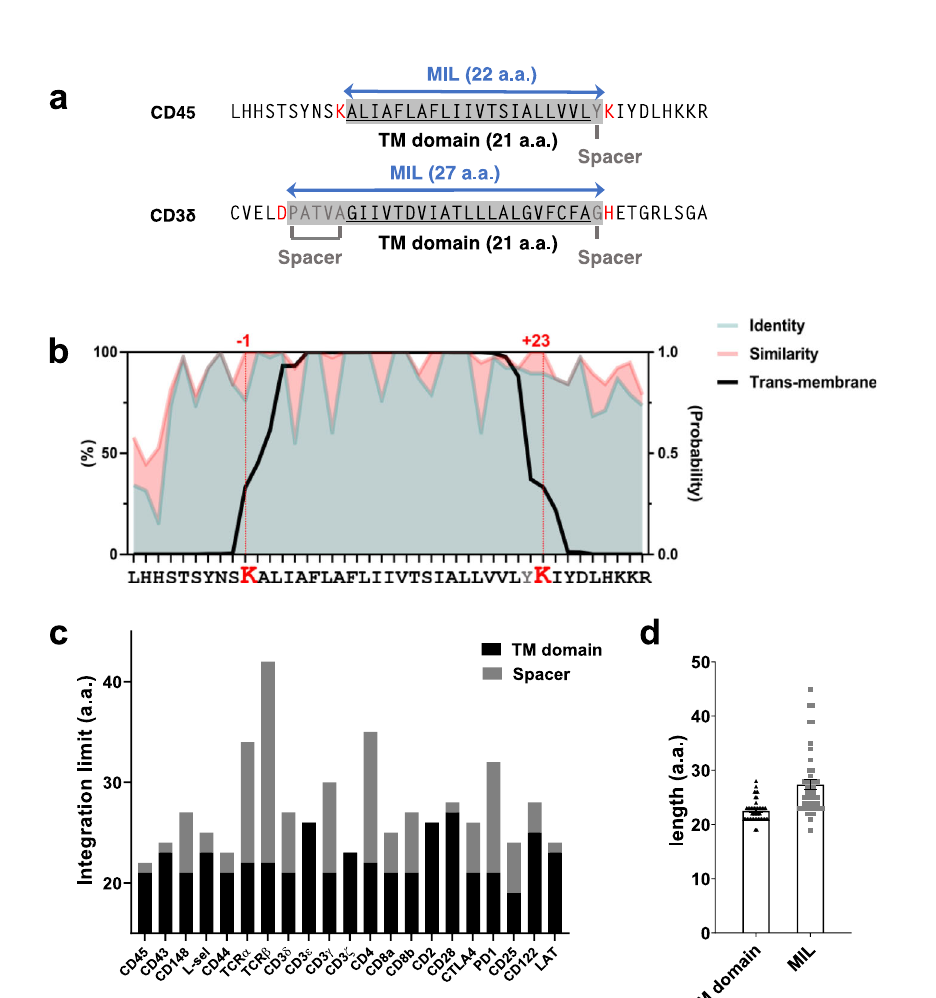
Fig. 4 Effect of M β CD on the distribution of surface CD45 molecules in human CD4 + T cells. a – d Representative 4x-ExM-Airyscan images of CD45 (green), CD3 (magenta), the merged, and RIS of representative untreated (M β CD – ) or M β CD-treated (M β CD + , 10 mM) resting ( a , b , respectively) and effector ( c , d , respectively) T cells. Magni fi ed images of the area marked in the merged images are presented in the right most panels. Scale bars: 2 µ m in the merge and the RIS images; 500 nm in the magni fi ed images. Images in a – d are representative of three independent experiments. e – f The median RIS values ( e ) and the mean SR ʹ values ( f ) within the segmented areas, (MV-tip area (Tip, black circle), MV-col area (Col, gray square), CB area (CB, dark gray upward-triangle), or entire cell (Cell, light gray downward-triangle)) were analyzed from each z-plane images (20 z-plane images per cell) of the resting T cells (M β CD – : 19 cells; M β CD + : 21 cells). Each dot represents data collected from a z-plane image. Bars represent the mean and error bars represent the SE. g , h The median RIS values ( g ) and the mean SR ʹ values ( h ) of effector T cells (M β CD – : 14 cells; M β CD + : 22 cells) were similarly analyzed as e , f . p values (ns (not signi fi cant), p > 0.05; * p ≤ 0.05; ** p ≤ 0.01; **** p ≤ 0.0001) were calculated by two-tailed Mann – Whitney test. Source data for e – h are provided as a Source Data fi le.